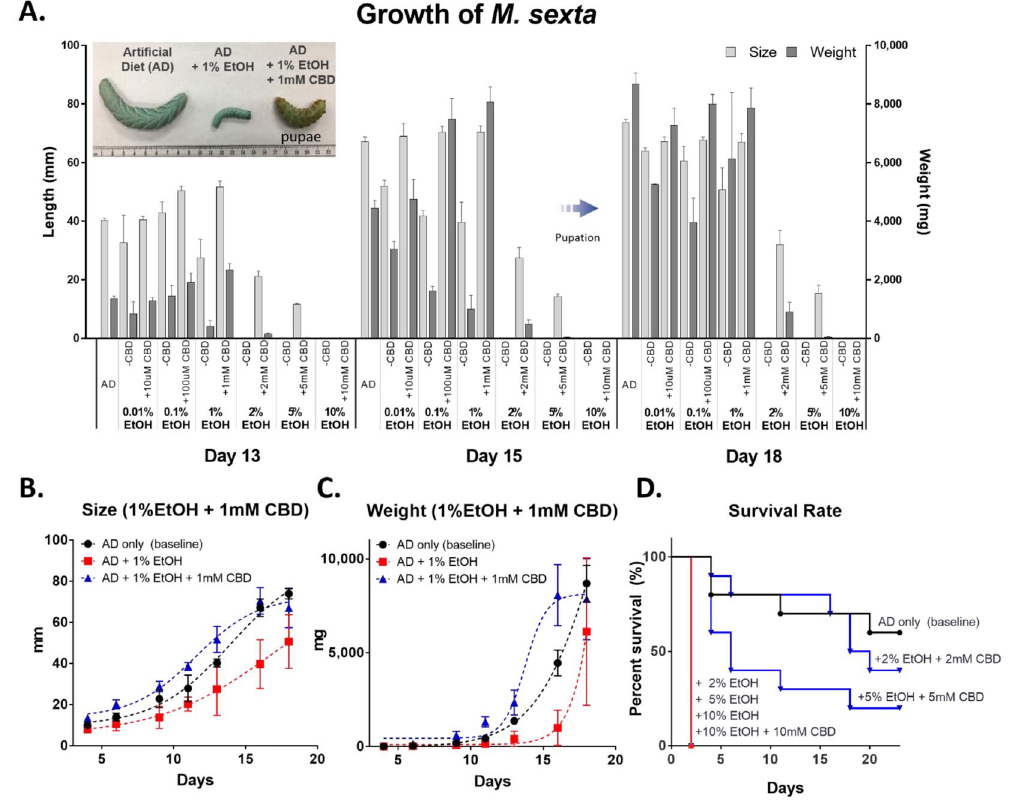
Figure 2. The effects of CBD on the growth and survival of M . sexta with EtOH solvent agent. ( A ) The size and weight increment between days 13 and 18. The inset in the upper left corner displays the size difference between larvae when fed different diets. Size ( B ) and weight ( C ) of insects reared on AD, AD + 1% EtOH, and AD + 1% EtOH + 1 mM CBD (one-way ANOVA with Tukey’s multiple comparisons test, n = 3~10, p < 0.05). ( D ) Survival rate of M . sexta larvae grown at 2%, 5%, and 10% of EtOH ± 2 mM, 5 mM, and 10 mM CBD concentrations (Mantel-Cox test, n = 5~10, p <